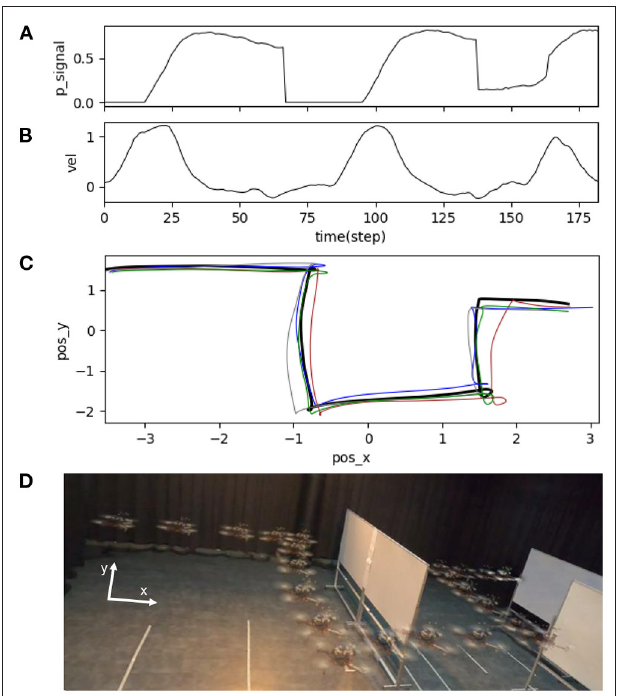
FIGURE 14 | Real-time data of speed adaptation with obstacle avoidance when flying the UAV in the real environment at a maximum speed of 1.0 m/s and a predictive weight of 1.07. (A) Predictive signal. (B) Actual speed (x-axis) of the UAV. (C) Position of the UAV plotting on the x-y axis to show its overall trajectory five times repeatedly. (D) Automatic flying behavior of the UAV (see from the left to right). A video of this experiment can be viewed on www. manoonpong.com/DSA/video5.mp4.